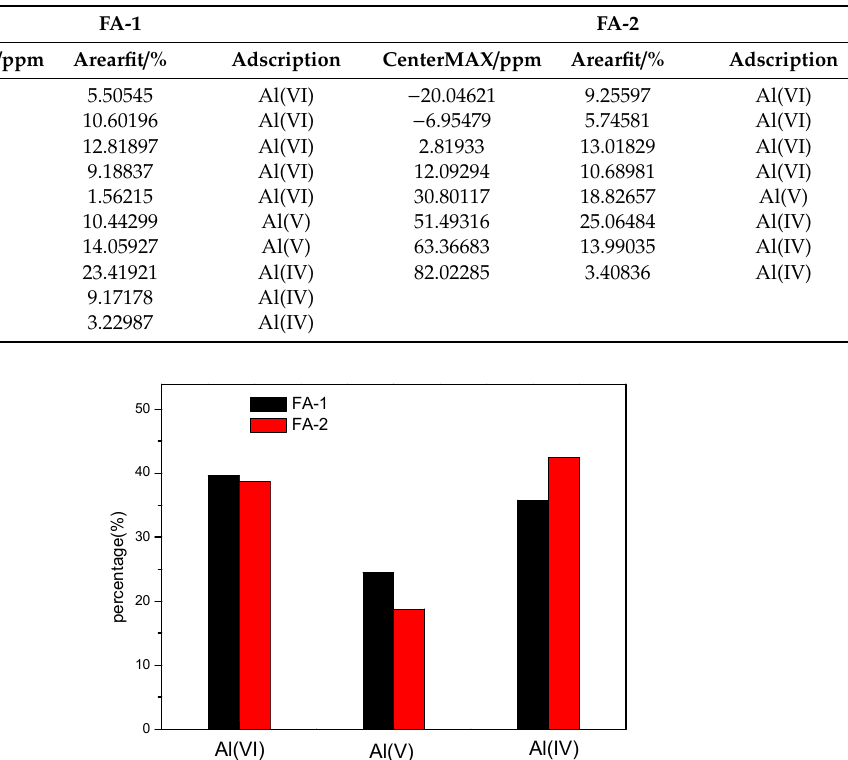
Figure 9. The 27 Al MAS–NMR spectra for FA-1 and FA-2. Table 5. The deconvolution results of the 27 Al MAS–NMR spectra for FA-1 and FA-2.